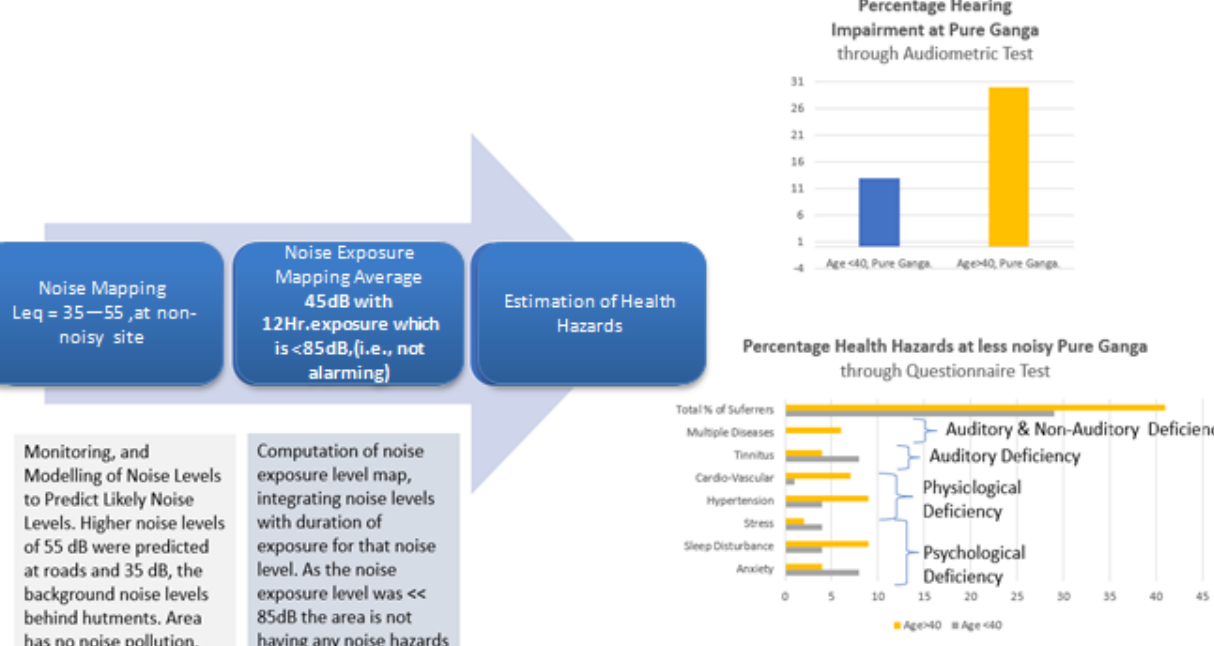
Figure 27. Health hazards of the non ‐ noisy Pure Ganga area. A total of 6% of people in the Bahadurpur intersection of the <40 age group complained about cardiovascular ailments which were only 1% in the case of Pure Ganga